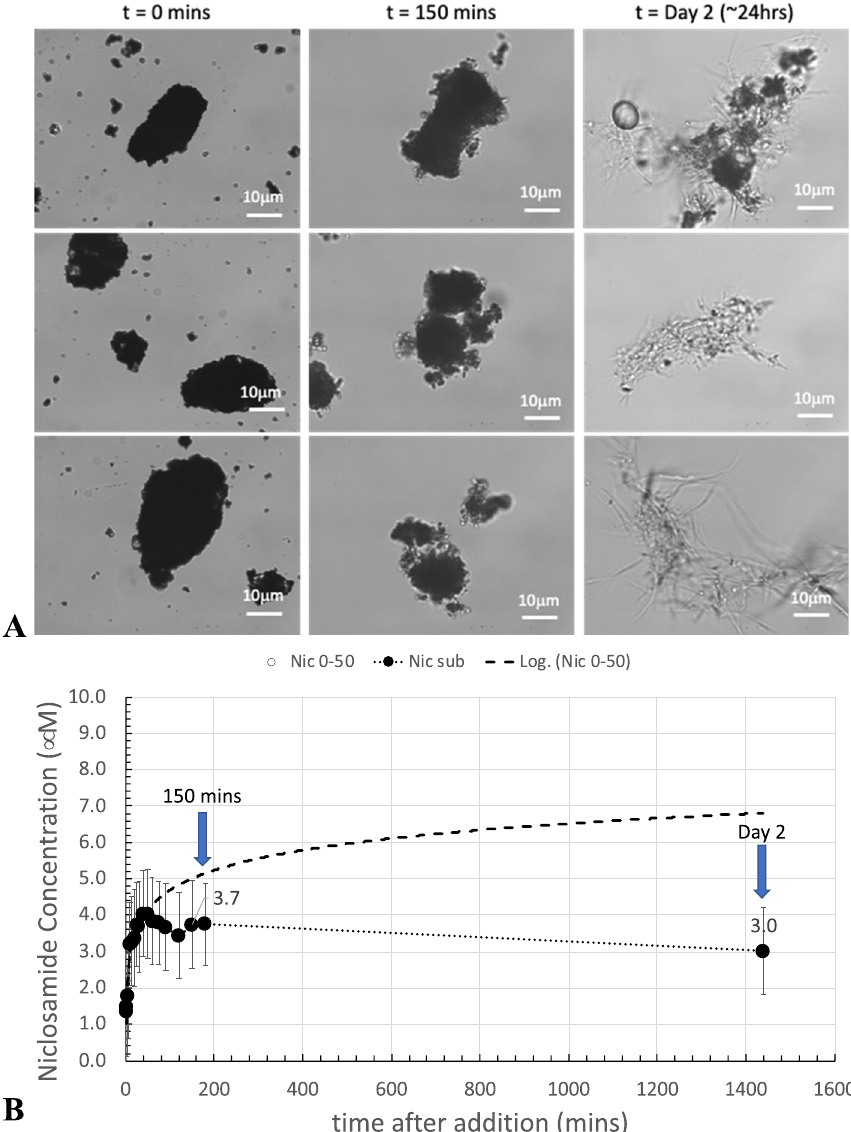
Fig. 13 Dissolution of Yomesan at nominal pH 7.41. A Three typical optical microscope images of Yomesan-niclosamide particles at each time point, before ( t 0 min), during ( t 150 min), and after equilibration (day 2). 40 = = optics (Nikon Diaphot). B Dissolution profile from Fig. 9A, extended to day